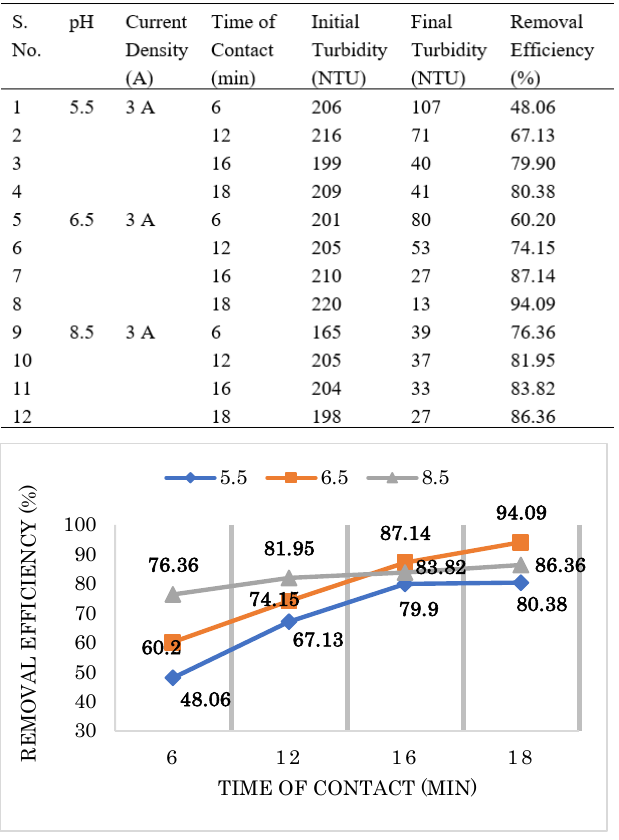
Fig. 5. Time optimization for turbidity removal for 3 A